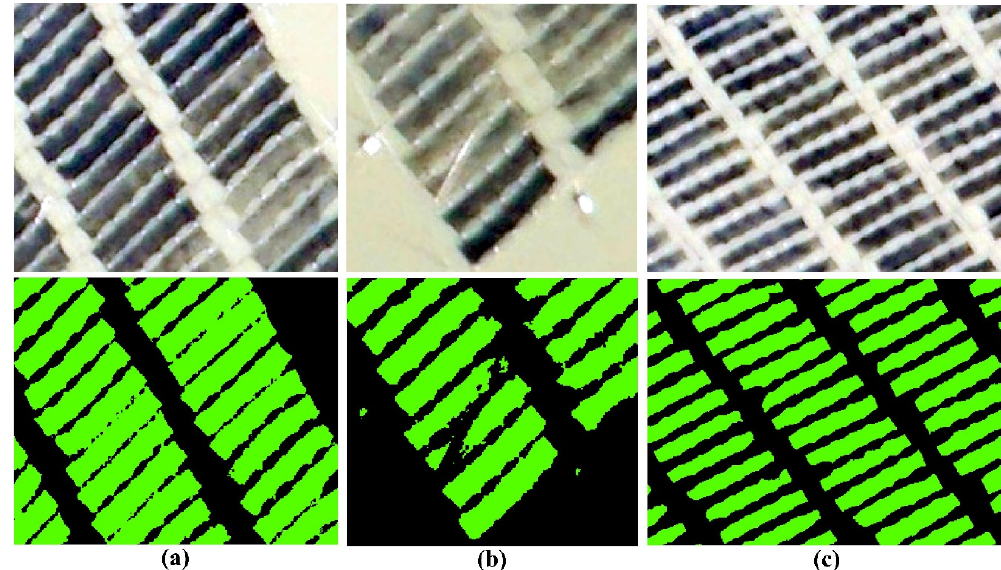
Figure 11. Details of the results after FCN-CRF. ( a – c ) represent remote sensing image and classification result of different regions.